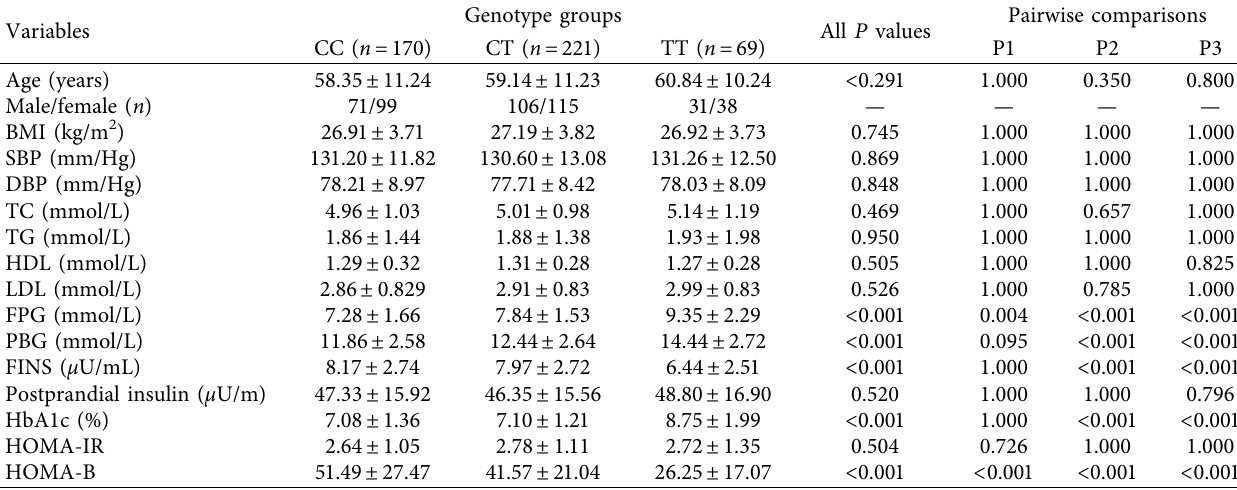
Table 5: Association of the ANGPTL 8 rs2278426 (C/T) polymorphism genotypes with biochemical parameters in the T2DM group.